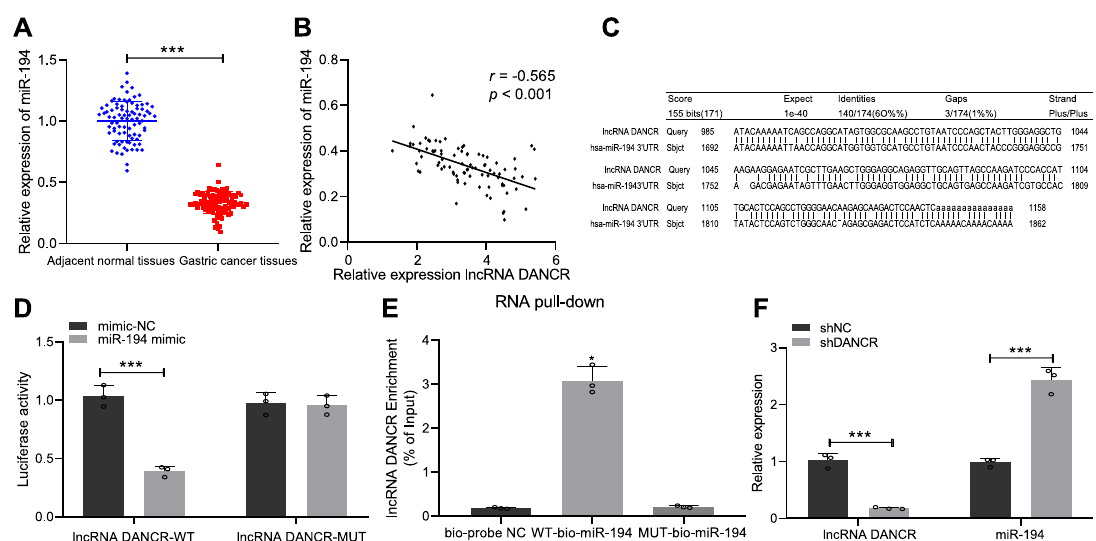
Fig. 4 DANCR acts as a ceRNA to sponge miR-194, thereby downregulating its expression in GC. A qRT-PCR to measure the expression of miR-194 in GC tissue and adjacent normal tissues ( n = 86); B correlation analysis between miR-194 expression and DANCR level; C the binding site miR-194 predicted through the Blast